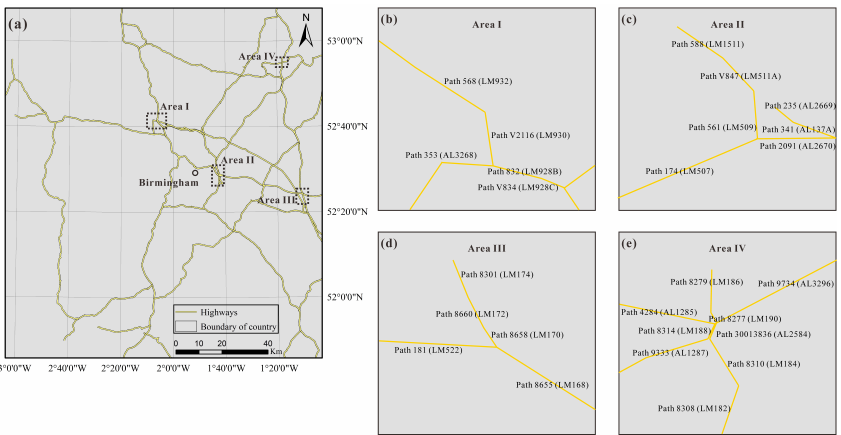
Figure 7. Study area: ( a ) paths near Birmingham; ( b ) part paths in Area I; ( c ) part paths in Area II; ( d ) part paths in Area III; ( e ) part paths in Area